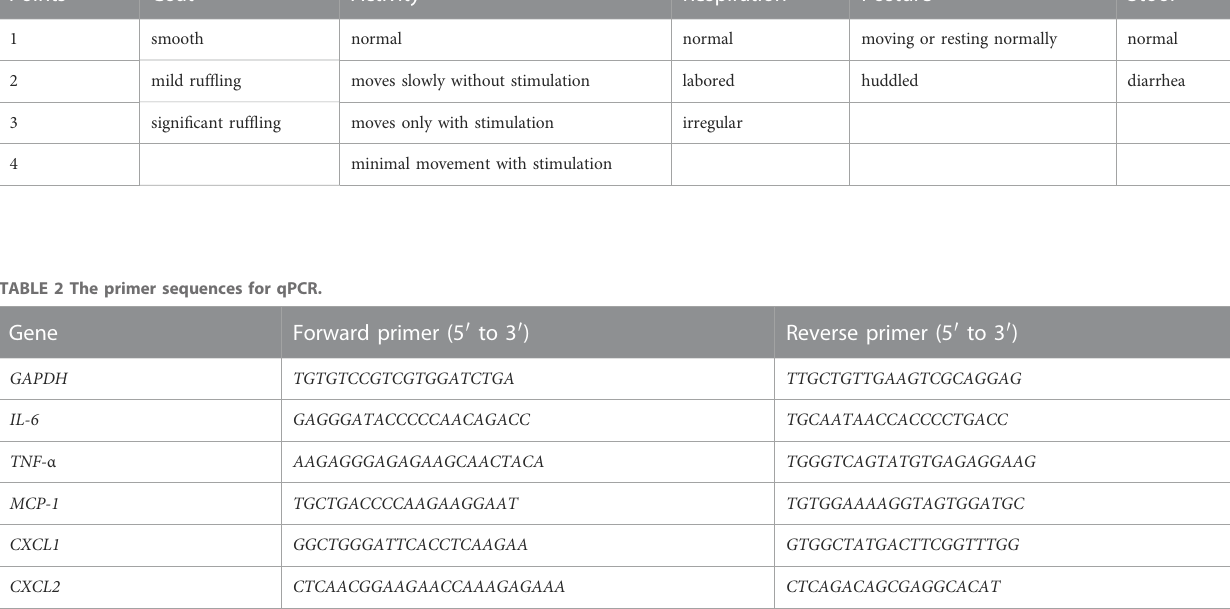
TABLE 1 The scoring points for clinical evaluation. Points